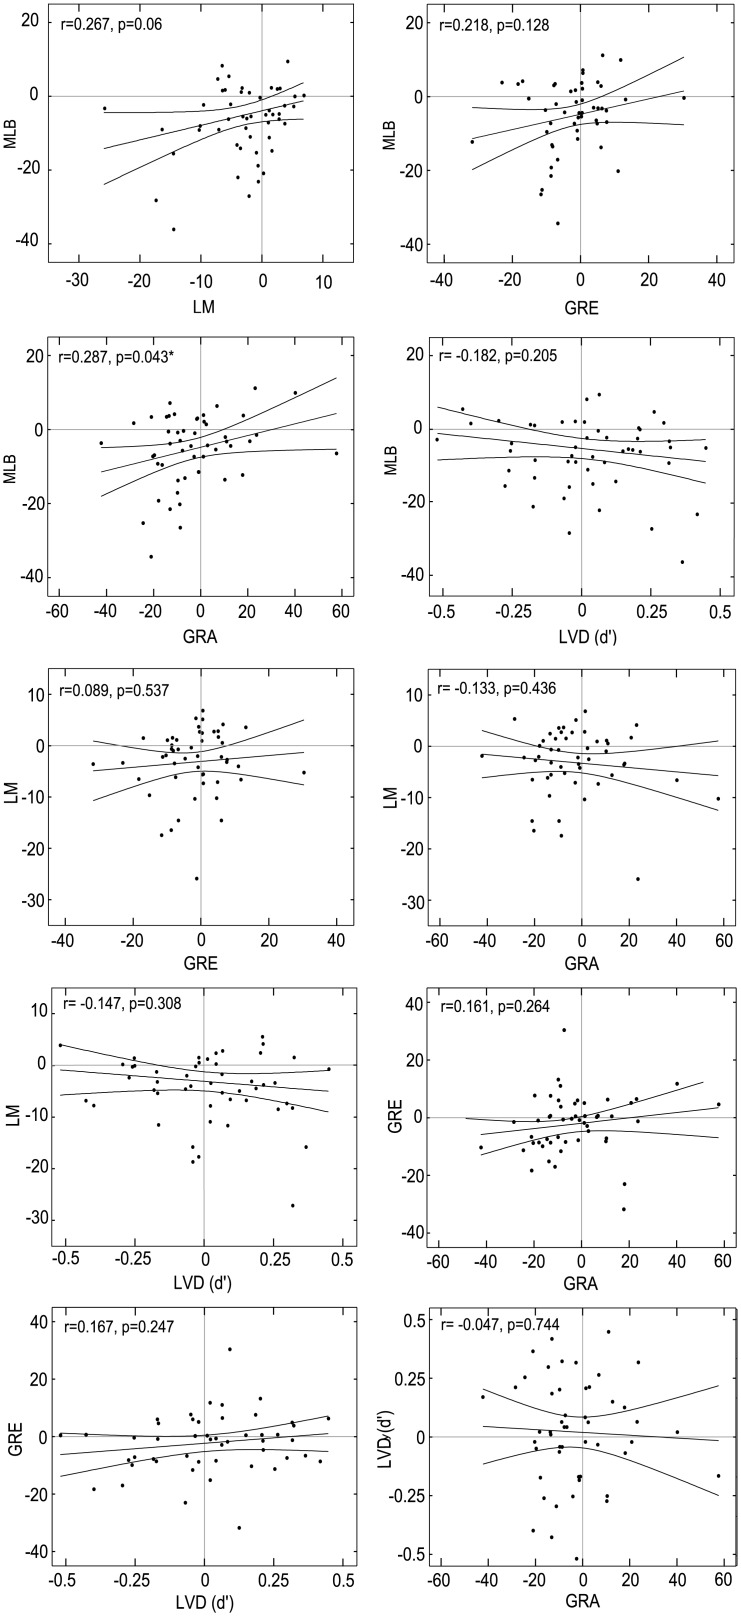
Inter-task correlations.Only the mean task biases (Day 1 and Day 2 averaged) for the MLB and GRA tasks were significantly correlated at α = 0.05 prior to correction, with all other comparisons p>0.05. * represents significant correlation at α = 0.05 but not when Bonferroni corrected to α = 0.005.